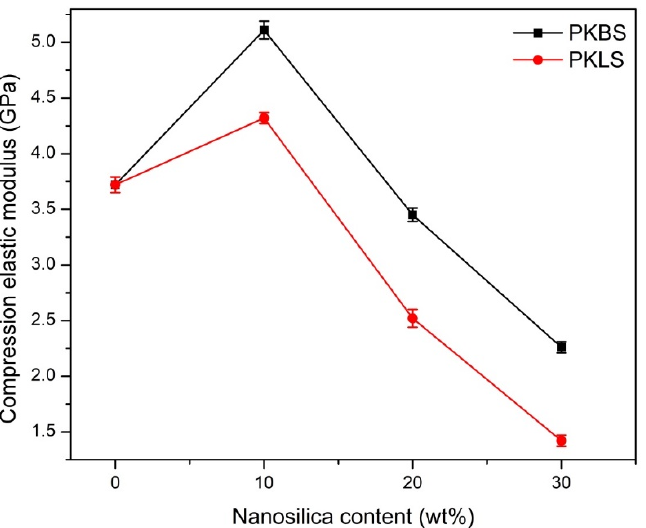
Figure 6. Mean value and standard deviations (mean ± SD) of elastic compression modulus for the PEEK/SiO 2 nanocomposites as a function of the nano-SiO 2 content. ( n = 7).